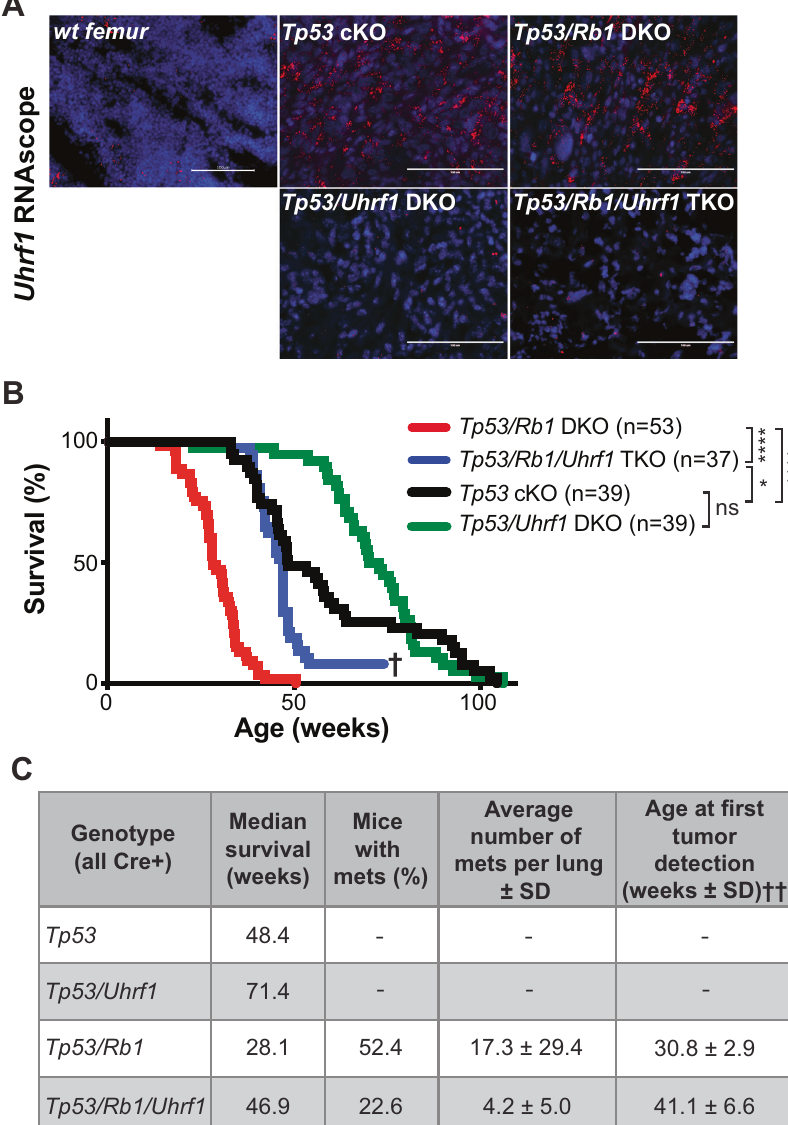
Fig. 6 UHRF1 is a critical driver of the increased malignancy observed in RB-null osteosarcoma. A Representative fl uorescent images of in situ hybridizations using RNAscope on wild-type femurs or tumors from genetically engineered osteosarcoma mice using a probe against Uhrf1 (red). Nuclei were counterstained with DAPI (blue). Uhrf1 expression is detected in Tp53 cKO and Tp53/Rb1 DKO mouse tumors but is low or not detected in wt, Tp53/Uhrf1 DKO, and Tp53/Rb1/Uhrf1 TKO tumors. B Kaplan – Meier curves showing the survival of osteosarcoma mouse models. Mice bearing Rb1 mutations Tp53/Rb1 DKO: Osx-Cre; p53 lox/lox ; Rb1 lox/lox (red; n = 53) have signi fi cantly shorter lifespan compared to Tp53 cKO: Osx-Cre; p53 lox/lox ; Rb1 lox/lox (black; n = 39). This survival time was signi fi cantly increased in Tp53 / Rb1 / Uhrf1 TKO: Osx-Cre; p53 lox/lox ; Rb1 lox/lox ; Uhrf1 lox/lox (blue; n = 37) mice. † Three surviving mice were removed from the study to con fi rm tumor absence. Tp53 / Uhrf1 DKO: Osx- Cre; p53 lox/lox ; Uhrf1 lox/lox (green; n = 39) showed an overall survival comparable to Tp53 cKO (black; n = 39). Mantel – Cox test were used for curve comparisons. ns not signi fi cant, * P < 0.05, **** P < 0.0001. C Summary table for each osteosarcoma mouse model. †† Age of mice (weeks) at earliest tumor detection via microCT and PET scans comparison: P < 0.05 by unpaired two-tailed t test; Tp53/Rb1 DKO ( n = 4) and Tp53 / Rb1 / Uhrf1 TKO ( n =